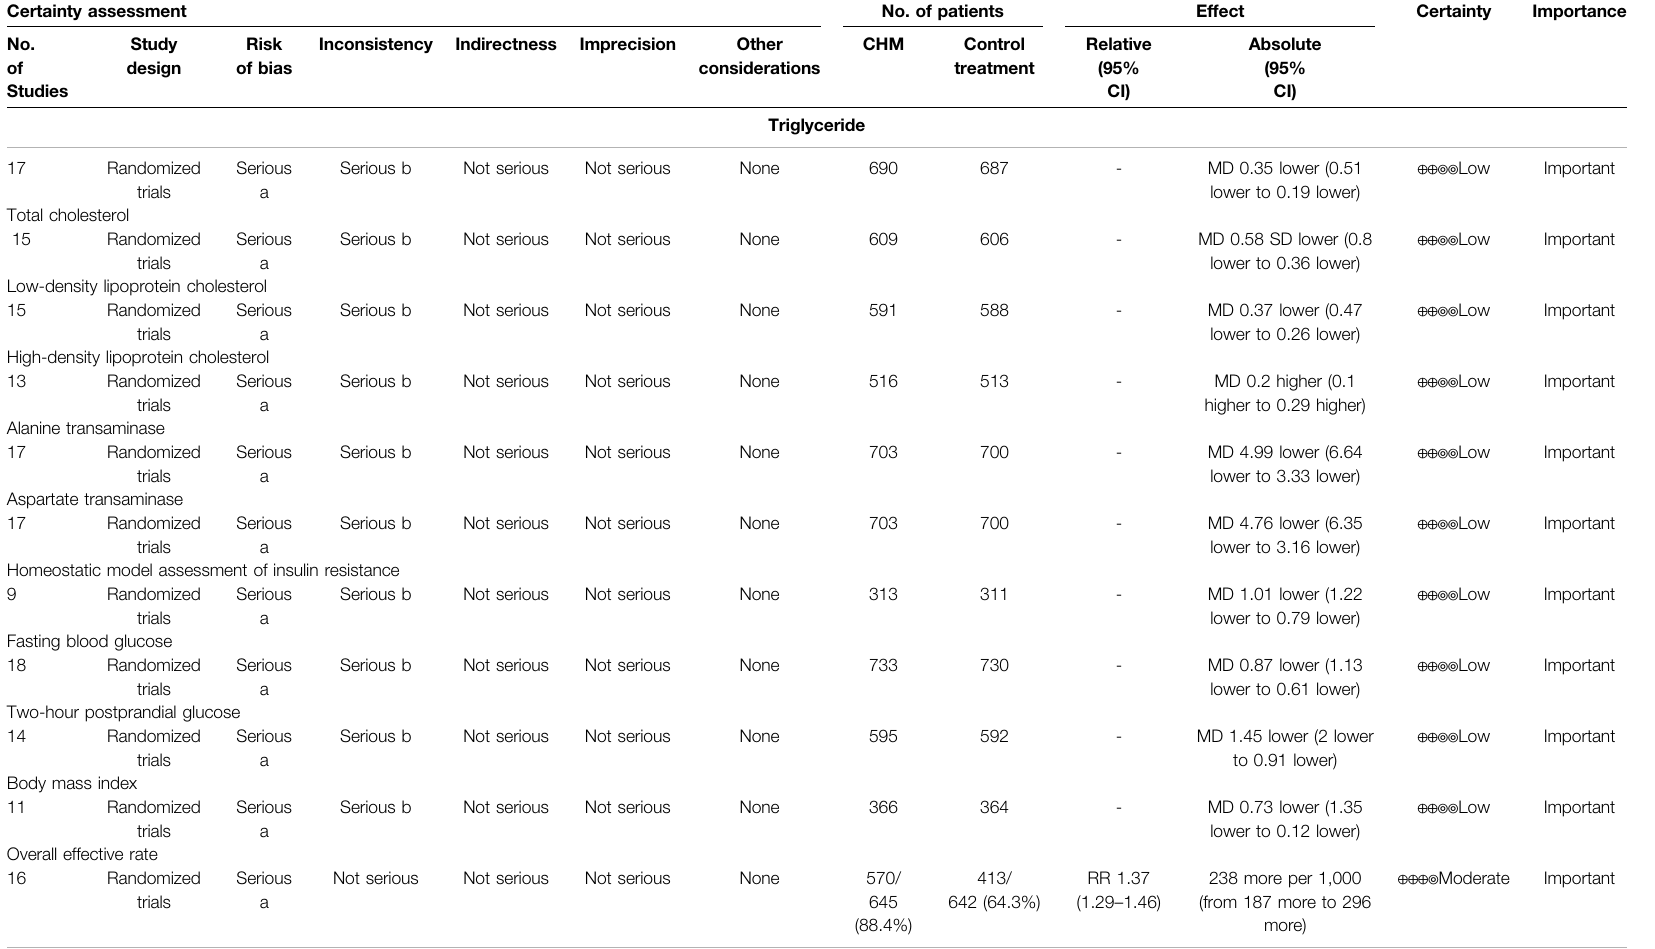
TABLE 4 | Certainty of evidence: CHM compared to control treatment for T2DM with NAFLD. Certainty